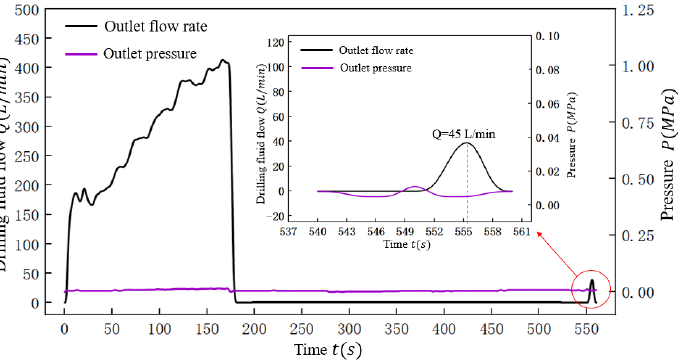
Figure 17. Outlet fluid flow rate and pressure of Experiment II and Experiment III changed with time.